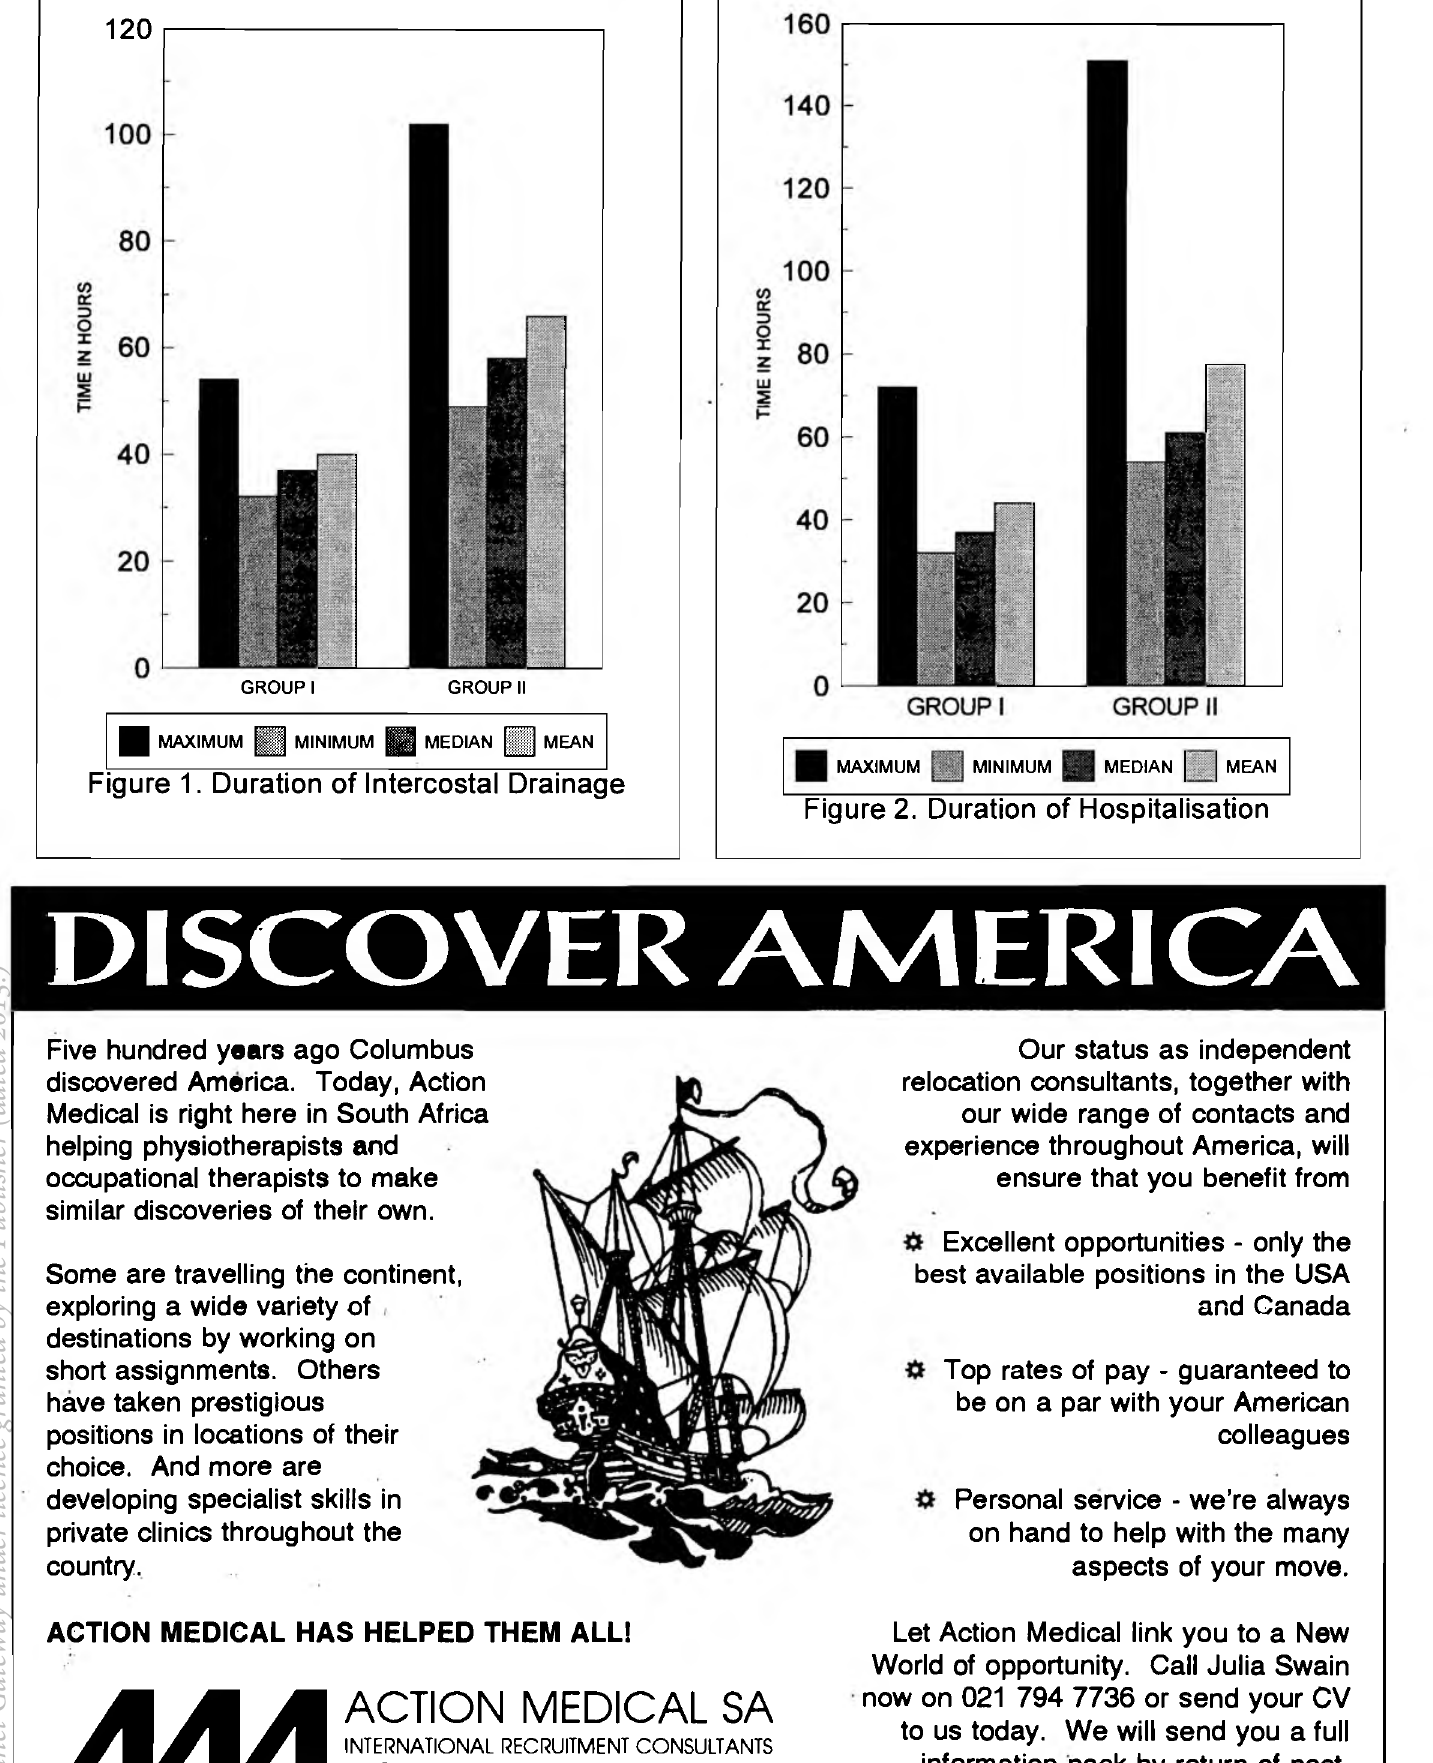
Figure 1. Duration of Intercostal Drainage